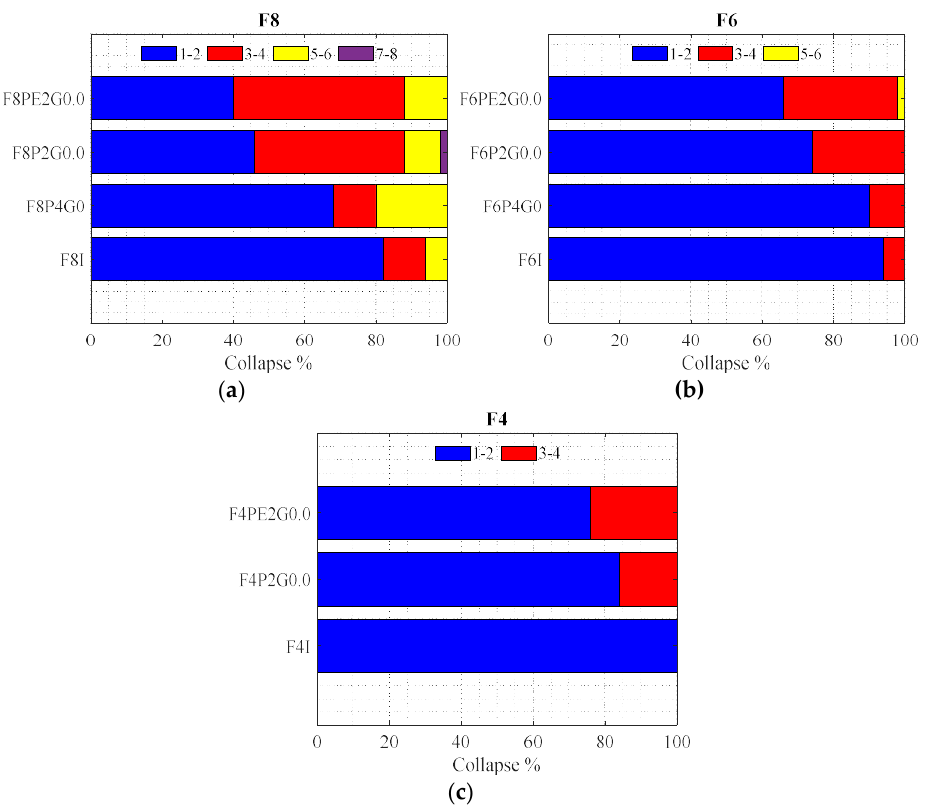
Figure 18. Percentage of global failure mechanisms along the height for different types of structures and pounding configurations: ( a ) all cases involving 8 storey structures, ( b ) all cases involving 6 storey structures and ( c ) all cases involving 4 storey